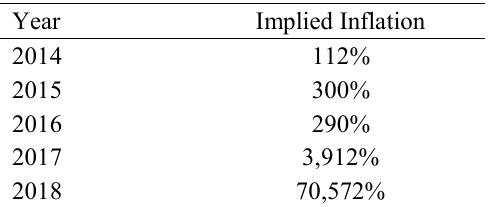
Table 7. Venezuela: Implied Inflation